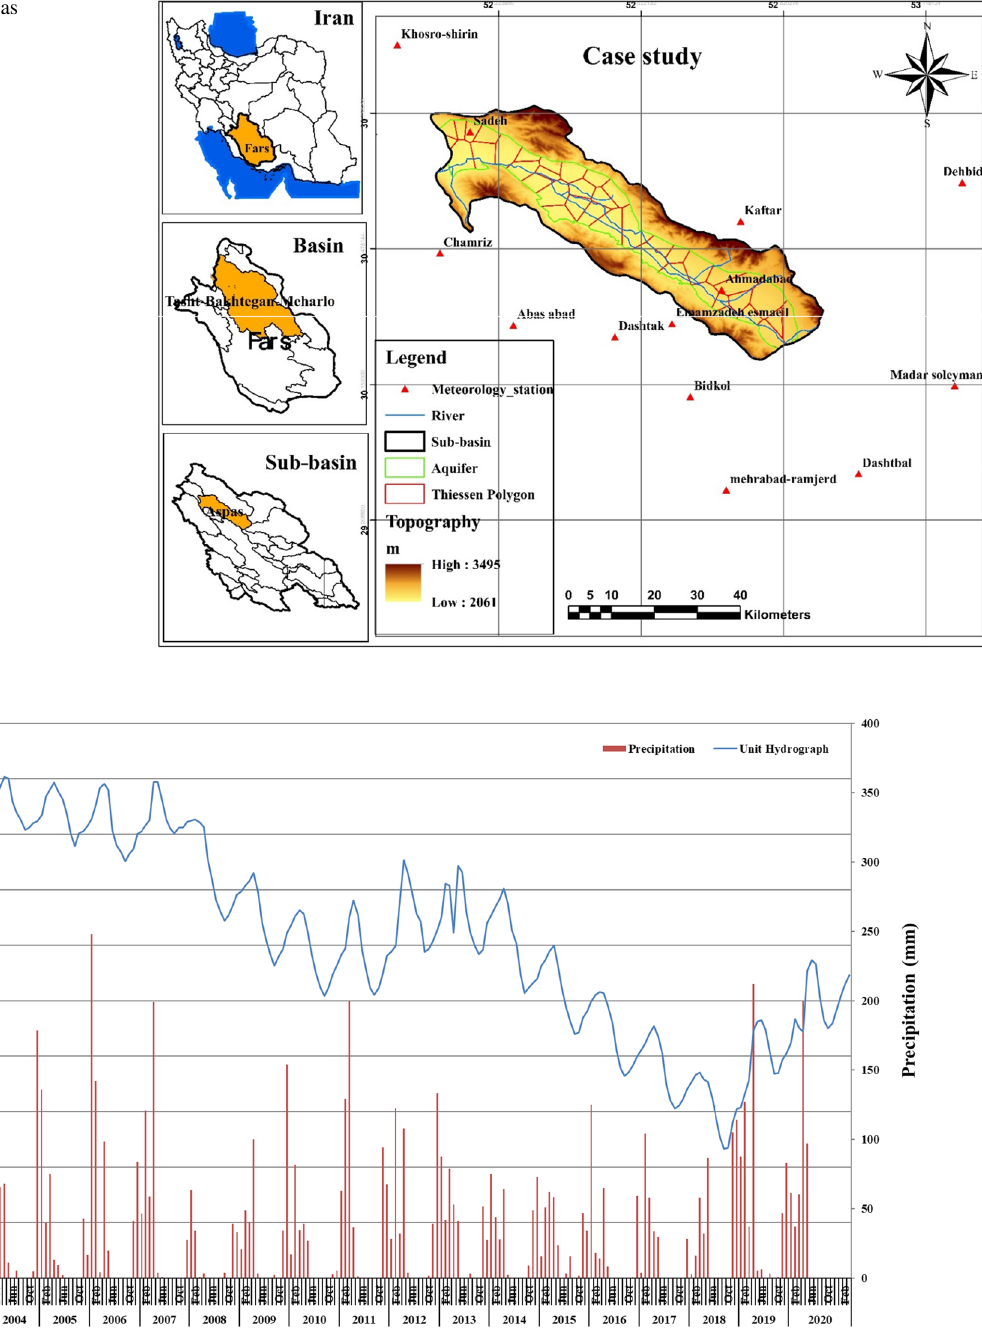
Fig. 1 Location of the Aspas